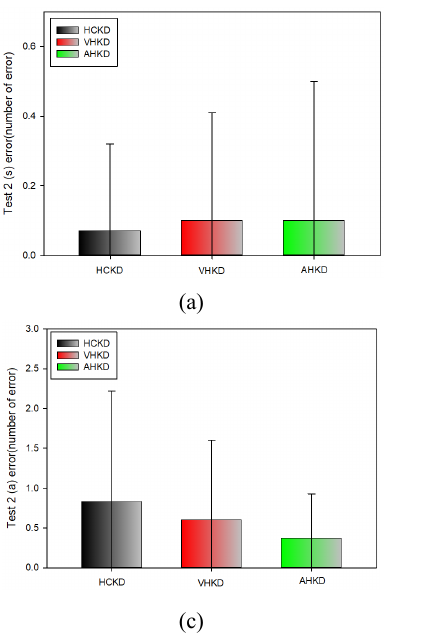
Figure 15. Frequency of error occurrence in Test 2(*: p <